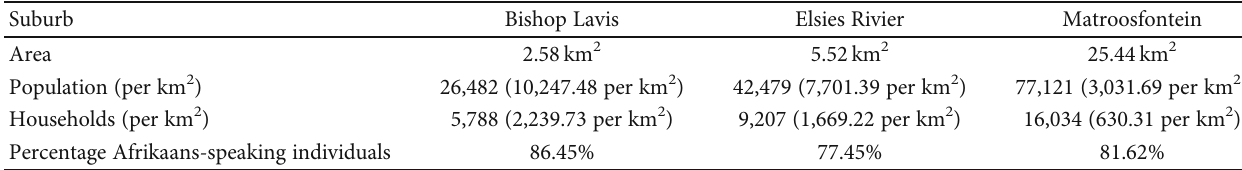
Table 1: Population and setting characteristics.